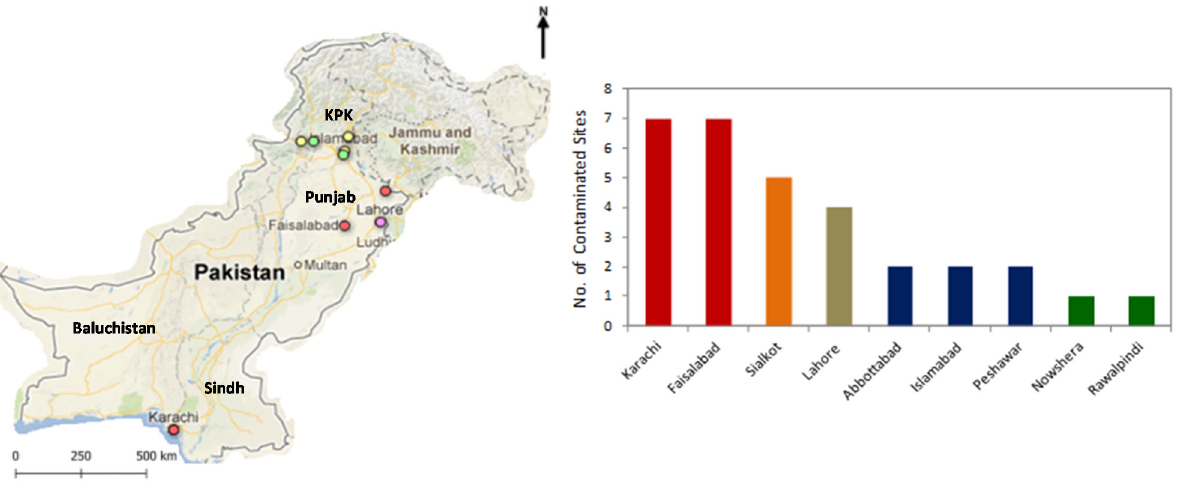
Figure 2. Distribution of contaminated sites in Pakistan.